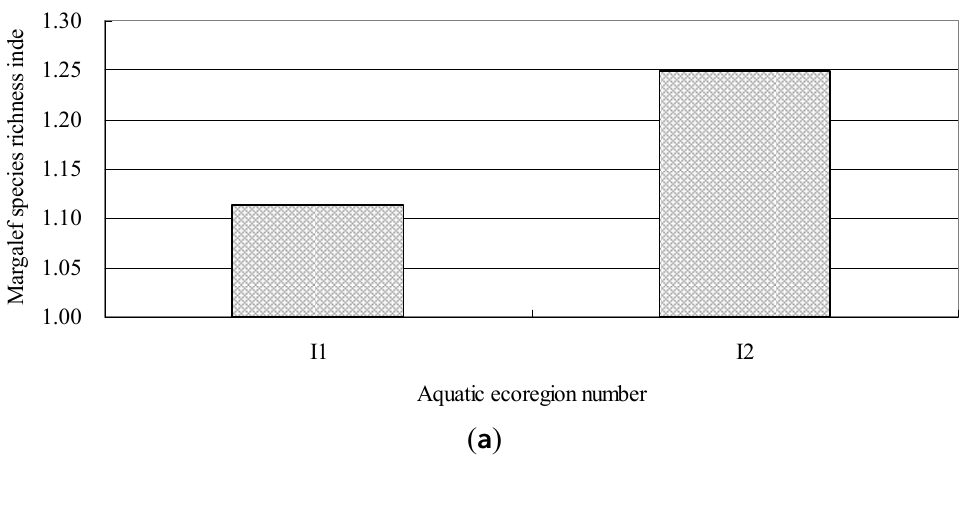
Figure 4. Benthic index in different aquatic ecoregions and subecoregions in Taihu Lake watershed. ( a ) Margalef species richness index in level I aquatic ecoregions; ( b ) Shannon- Wiener diversity index, Pielou evenness index and ecological dominance in level I aquatic ecoregions; ( c ) Margalef species richness index in level II aquatic subecoregions; ( d ) Shannon-Wiener diversity index, Pielou evenness index and ecological dominance in level II aquatic